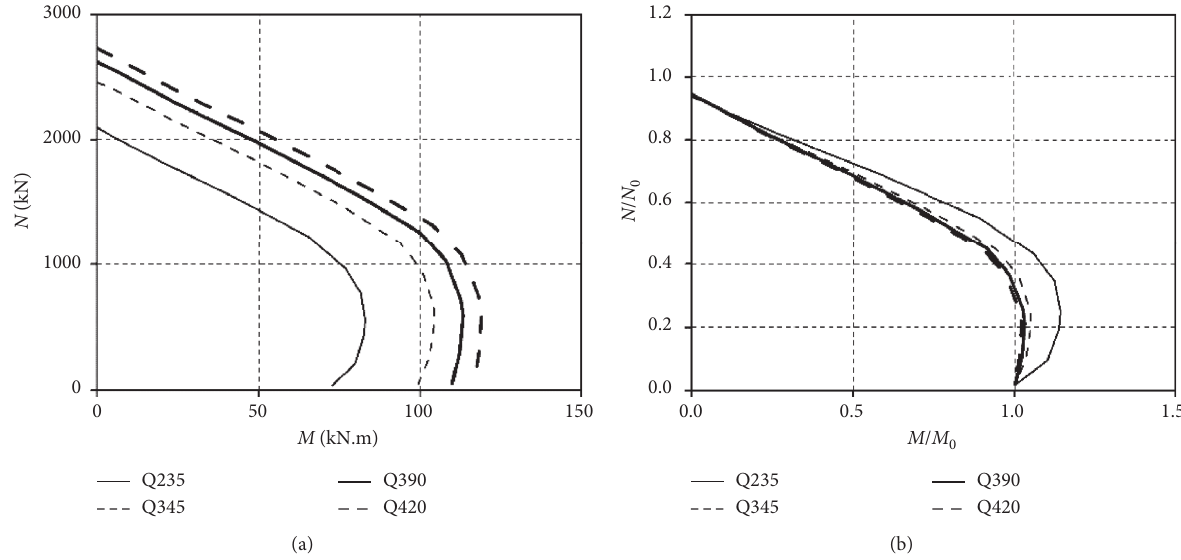
Figure 14: Influence of steel yielding strength fy on component-based resistance correlation curves. (a) Slenderness ratio of 20. (b) Slenderness ratio of 20